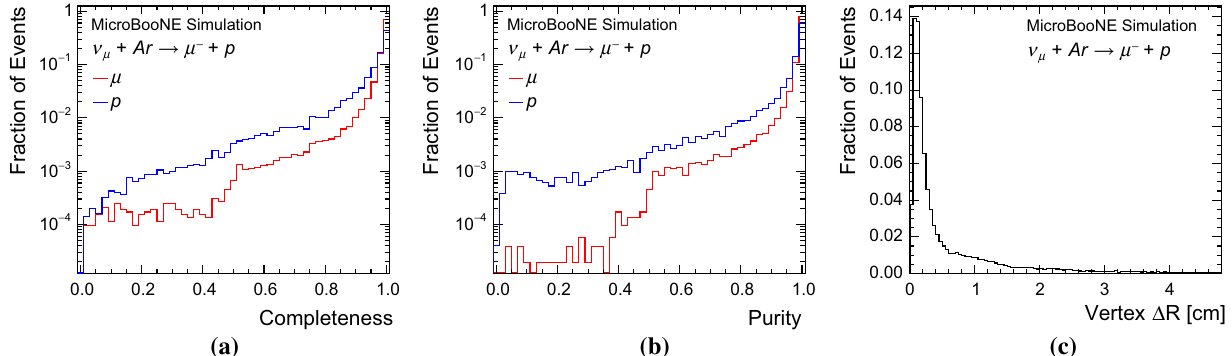
Fig. 13 Completeness ( a ) and purity ( b ) of the reconstructed particles with the strongest matches to the target muon and proton in simulated BNB CC ν μ quasi-elastic interactions and c the distance between generated and reconstructed 3D vertex